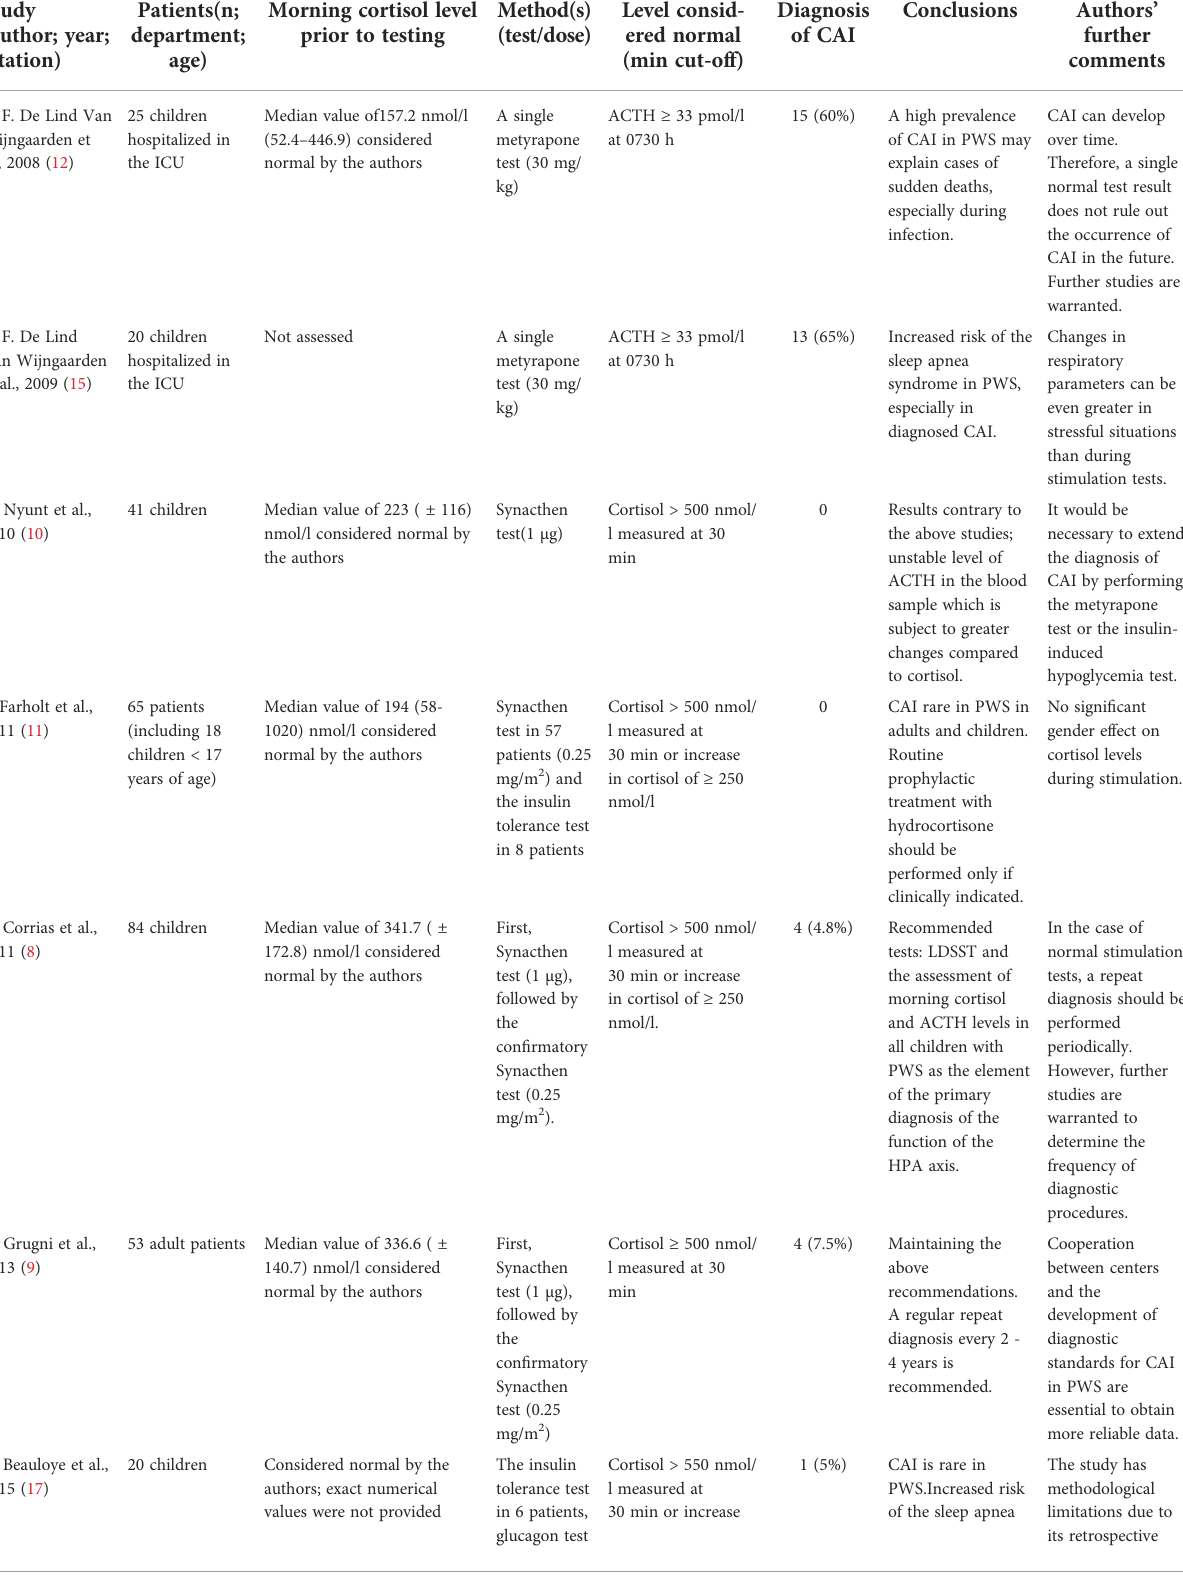
TABLE 1 Summary of the protocols and the results of the stimulation tests used by the